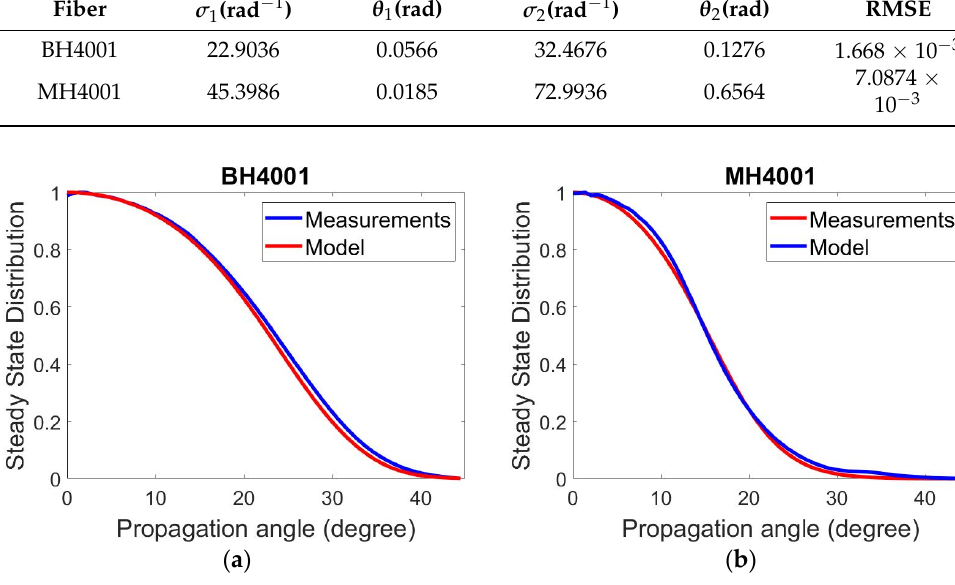
Figure 2. Normalized steady-state distribution function. ( a ) BH4001 fiber and ( b ) MH4001 fiber. The optical intensity distribution for the steady state is much narrower for the MH4001 fiber than for the BH4001, consistent with their different NAs. Table 1. Parameters for the fit of the SSD measurements for the BH4001 and MH4001 fibers.